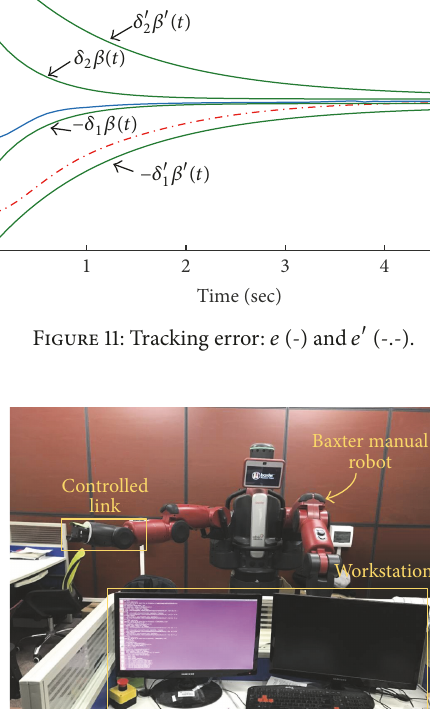
Figure 12: Overview of the experimental platform.